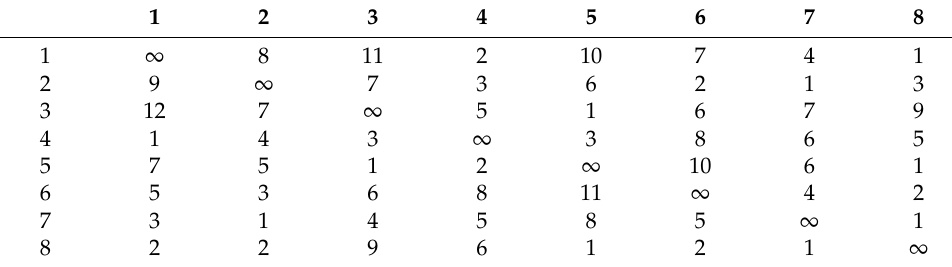
Table 2. The distances between eight